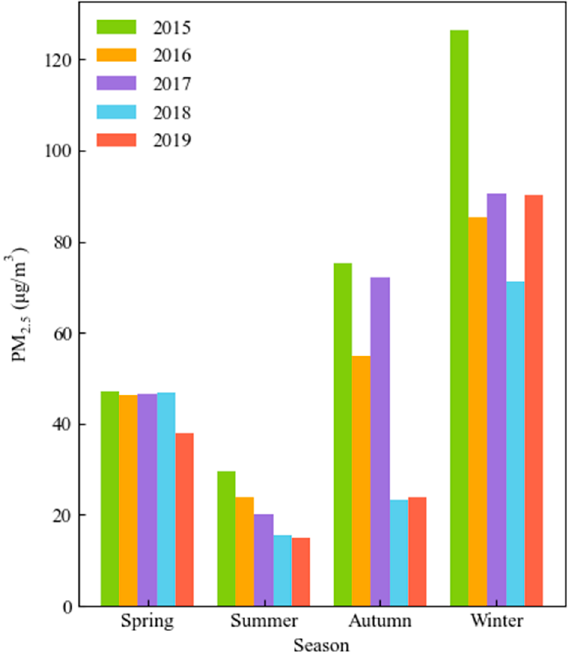
Figure 8. Seasonal changes in the PM 2.5 concentration.